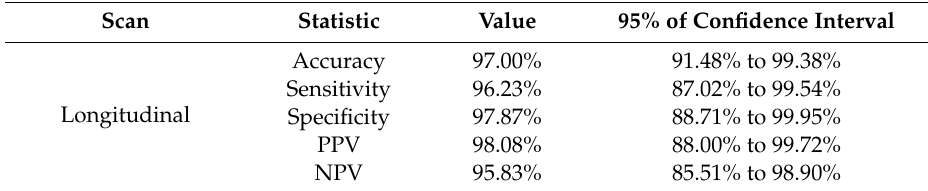
Table 5. Performance based on hybrid feature vector using longitudinal scan of OASBUD dataset. Ensemble (Preset: RUSBoosted trees, ensemble method: RUSBoost, learner type: Decision tree, maximum number of splits: 20, number of learners: 30, learning rate: 0.1)